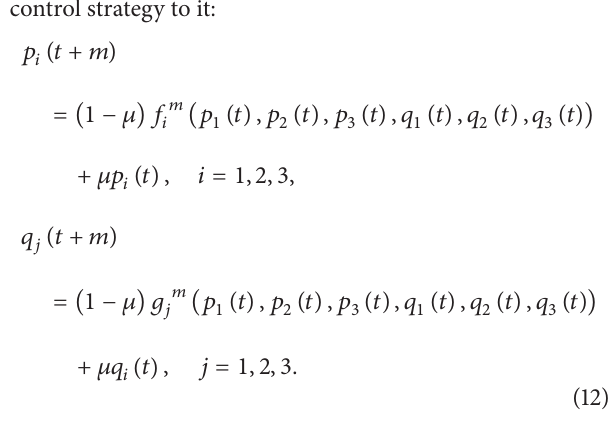
Figure 11: Average profit of the oligarchs with 𝛼 1